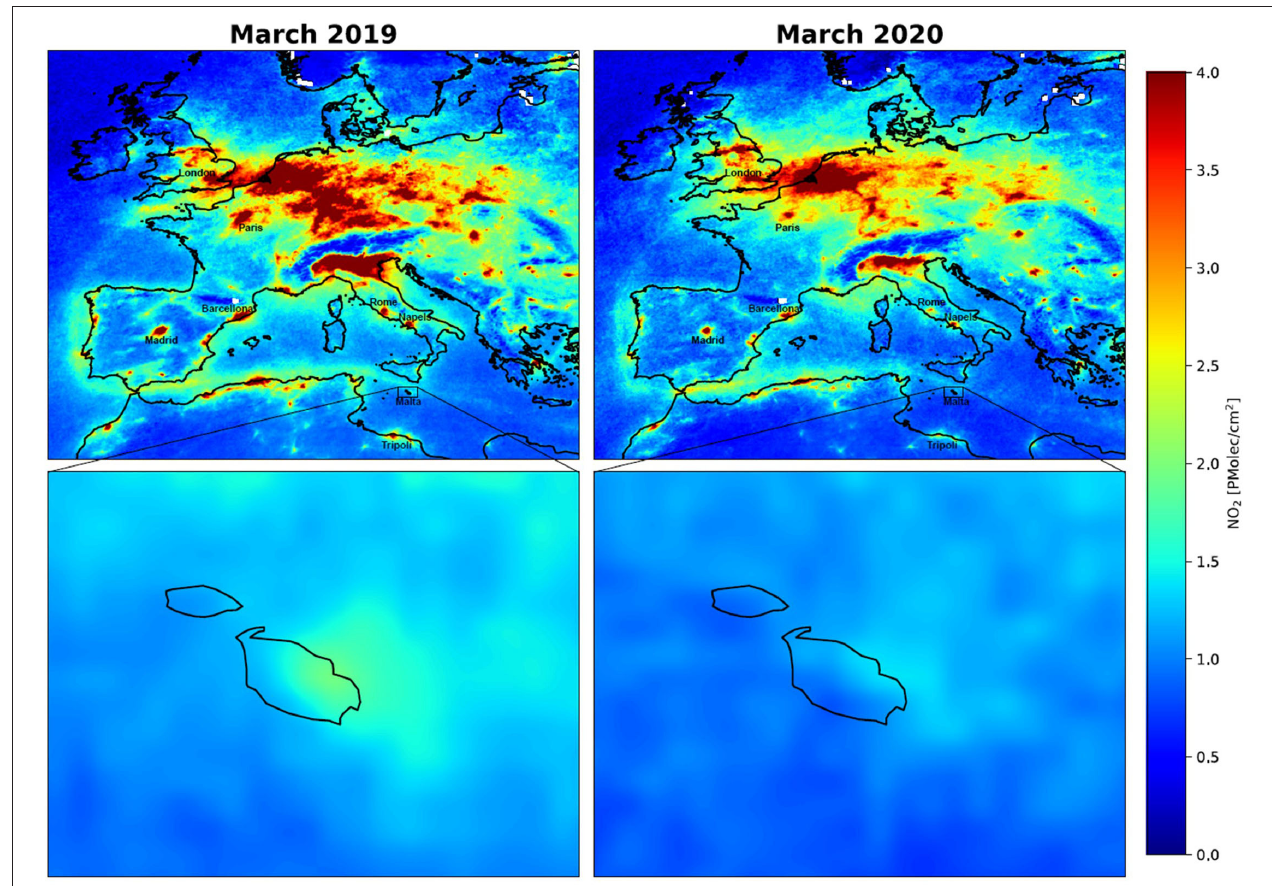
FIGURE 4 | NO 2 vertical column density over Europe (top panel) and the Mediterranean Sea (bottom panel) for March 2019 (Left) and 2020 (Right) .